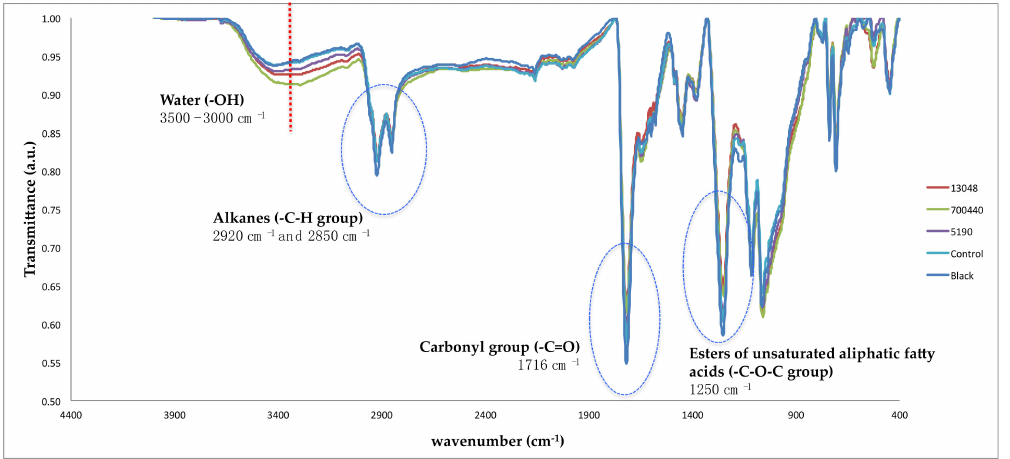
Figure 8. Infrared spectra of black powdered graffiti after treatment with bacteria. Black graffiti spray paint; control, without bacteria; 13,048 corresponds to Aerobacter aerogenes ; 700,440 corresponds to Comamonas sp., and 5190 corresponds to Pseudomonas stutzeri